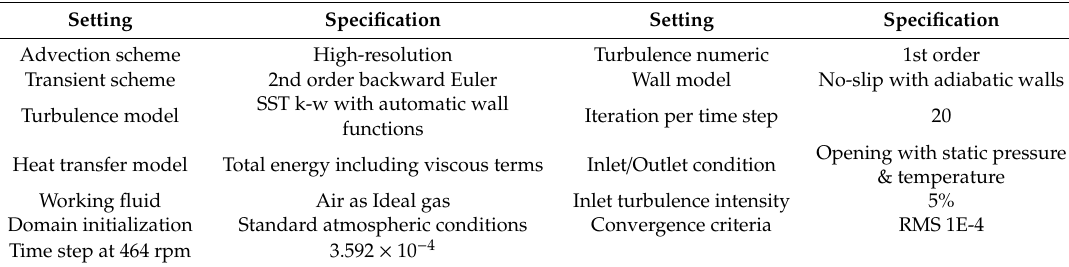
Table 3. CFD settings of the Roots blower.